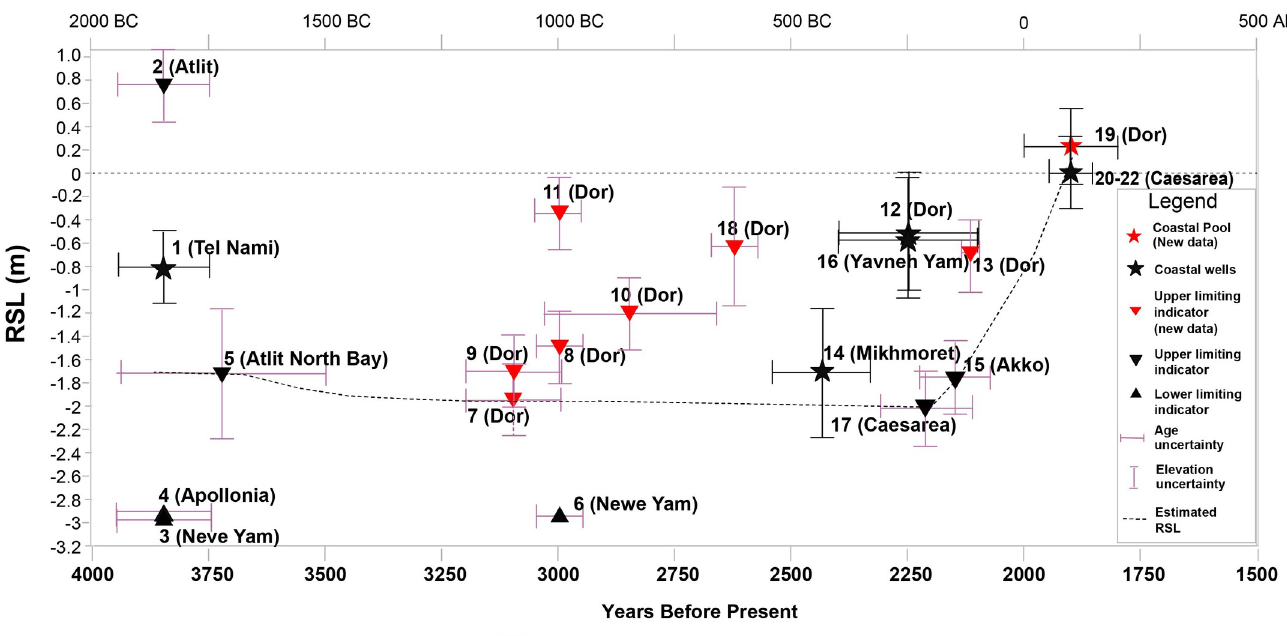
Fig 5. Computed relative sea level for the coast of Israel with the chronological and vertical uncertainties.